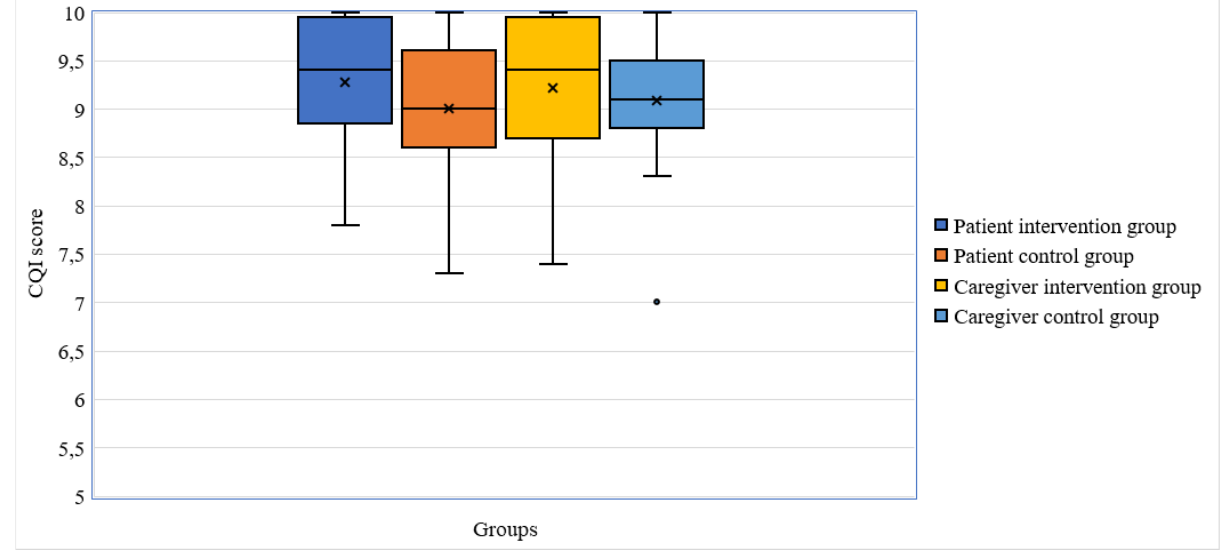
Figure 4. Box plots for total Consumer Quality Index (CQI) scores for patients (two box plots on the left) and caregivers (two box plots on the